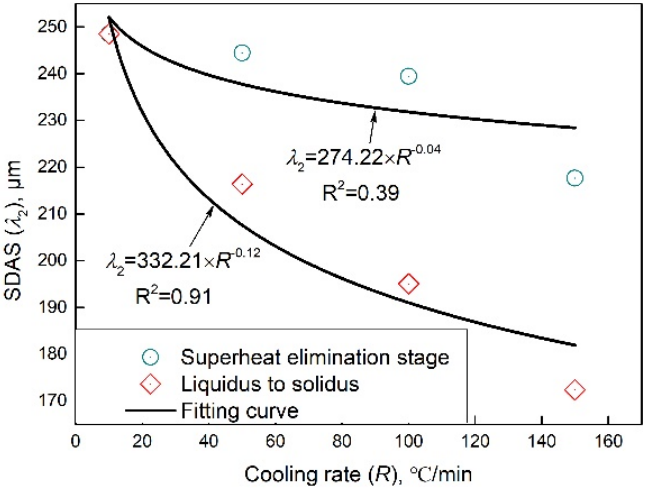
Figure 7. SDAS at different cooling rates.